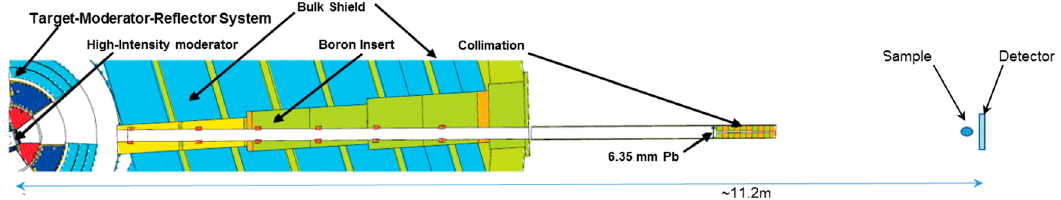
Figure 4. Flight Path 05 Schematic. Beyond the first 10 m station, there is an evacuated pipe and some large diameter polyethylene shielding leading to the 60 m station.